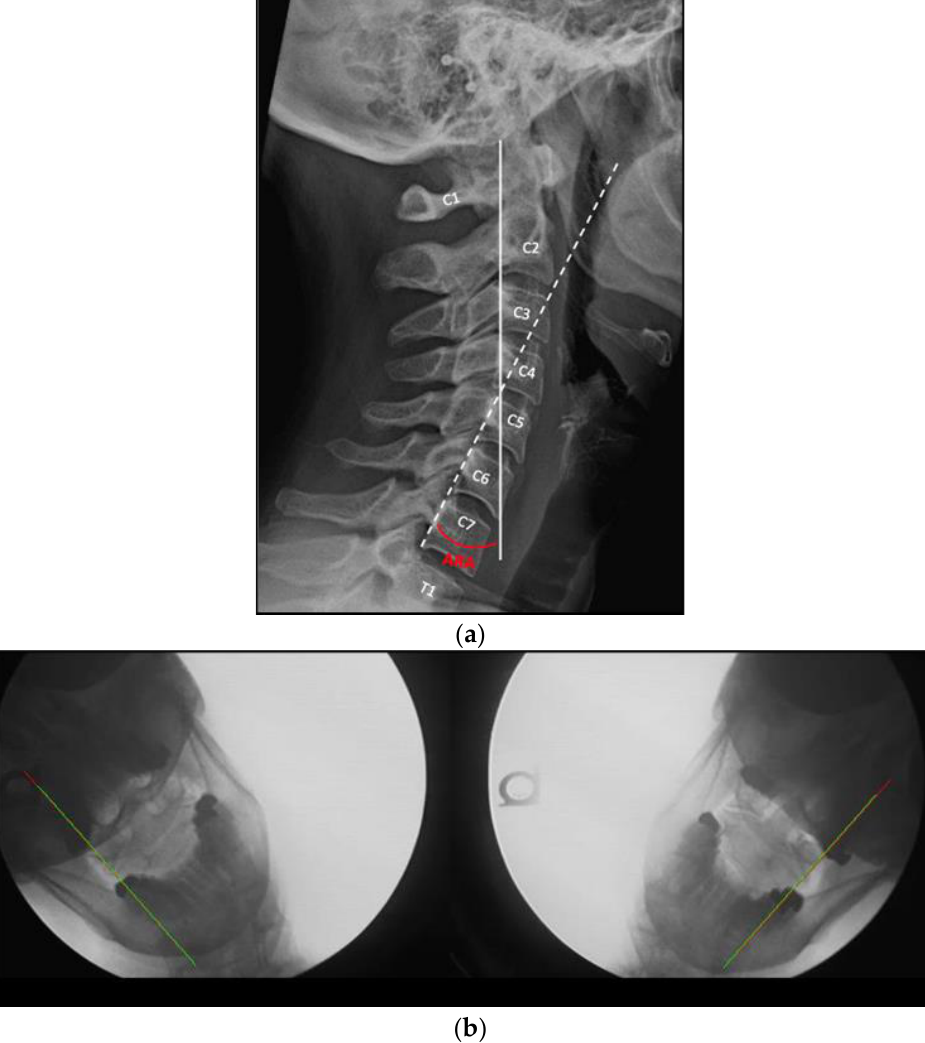
Figure 1. ( a ) Actual rotational angles (ARA) measurement in a patient with a normal cervical lordosis. The ARA (in red) indicates the angle between the posterior body margins of C2 (solid white line) and C7 (dashed white line). ( b ) AP open mouth lateral bending still shots from the DMX study (left and right lateral flexion on the left and right, respectively), with the green line indicating the lateral mass margin of C1, and the red line indicating the lateral body margin of C2. The lines overlap, indicating no overhang of C1 on C2.